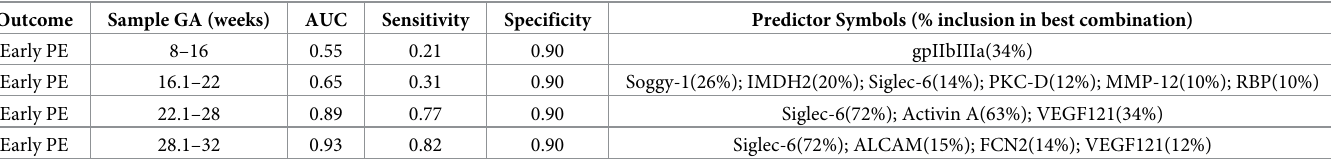
Table 3. Summary of bootstrap results for prediction of early preeclampsia versus normal pregnancy and late preeclampsia.